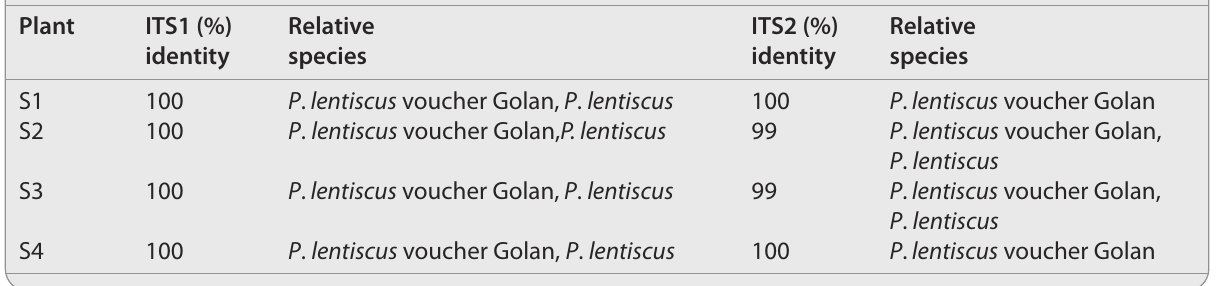
Table 7 Composition of the ITS1 and ITS2 sequences of plants belonging to “Stenophyllos” (S) Plant ITS1 (%)